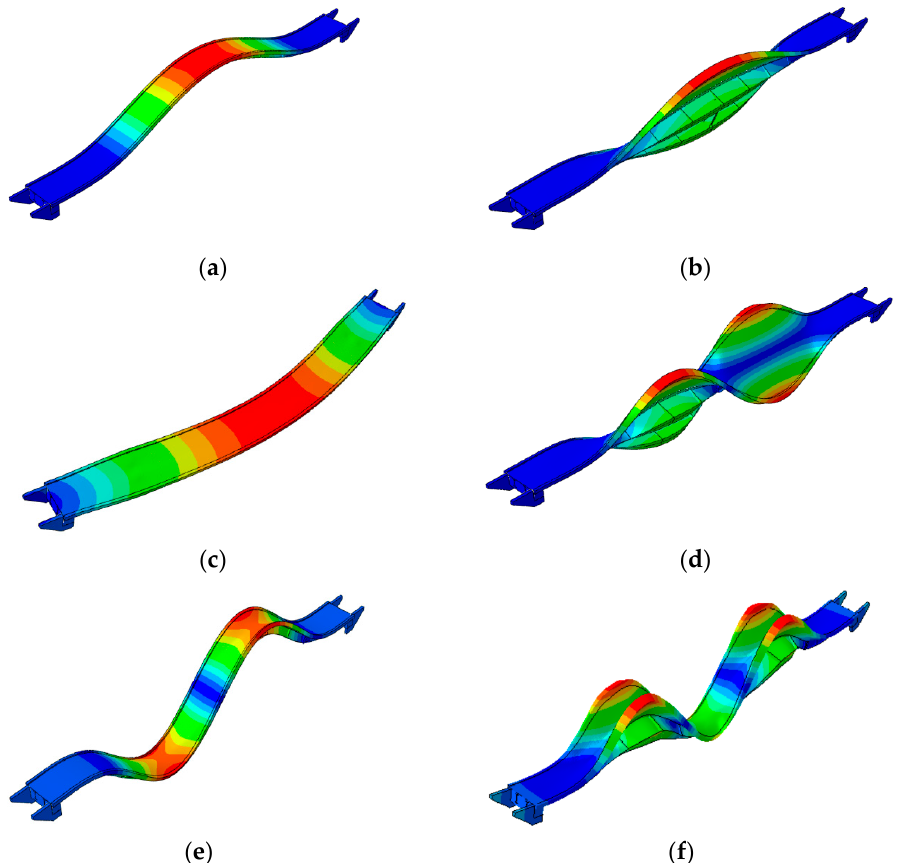
Table 6: (1) as far as the third horizontal mode is concerned the horizontal vector compo- nents are reported, while (2) regarding the other modes the vertical vector components were considered. The averaged percentage error has been evaluated for each normed eigenvector of the two alignments. The greater error value resulted in close to 5% for mode Figure 17. Sensitivity of the natural frequencies vs. adopted model: ( a ) evaluated values [Hz]; ( b ) percentage error. 3 of alignment A and 6% for mode 3 of alignment B.